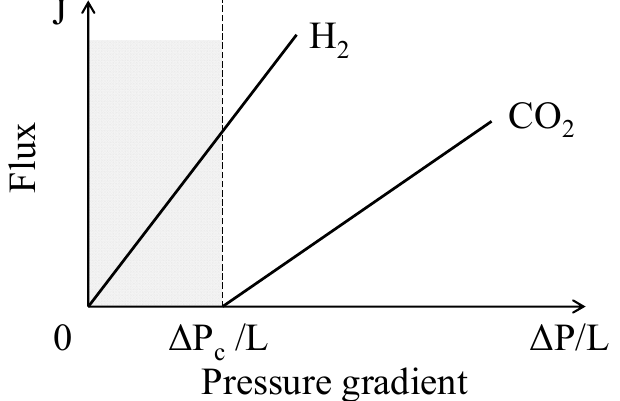
Figure 2. Schematic showing the flux–pressure gradient relation of H 2 and CO 2 gases through porous ceramics. A critical pressure gradient ( ∆ P c / L ) is observed for CO 2 gas.